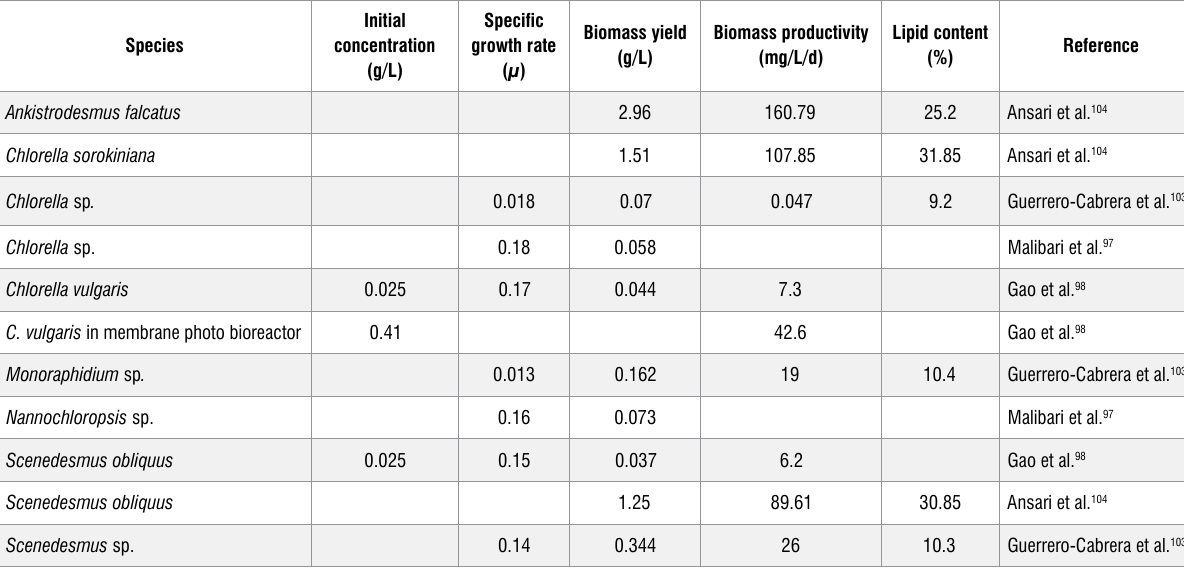
Table 6: Species, initial algae cultivation concentration, specific growth rate, biomass yield, biomass productivity, and lipid content of some microalgae cultivated in aquaculture